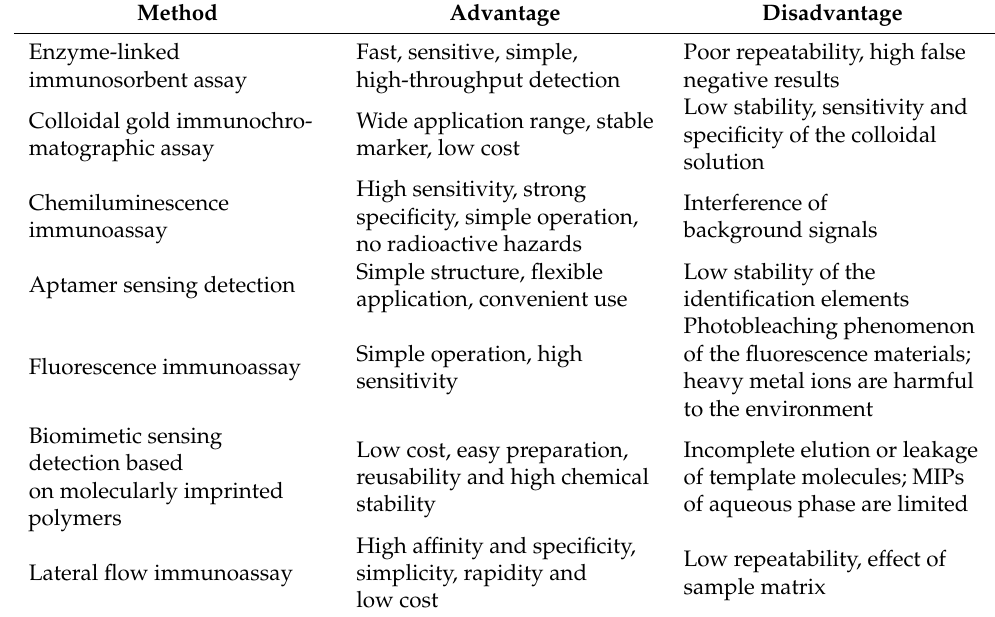
Table 3. Comparison of advantages and disadvantages of affinity-based analysis